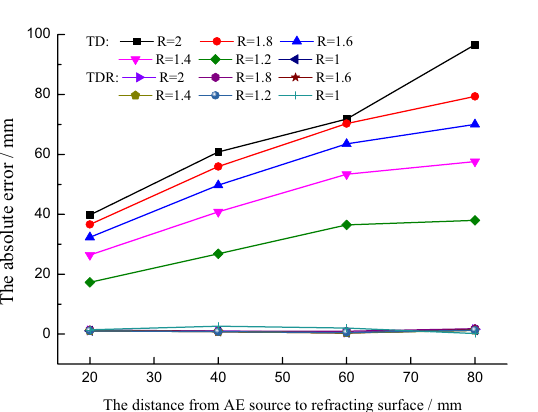
Figure 14. The location errors with different ratios of wave velocity.